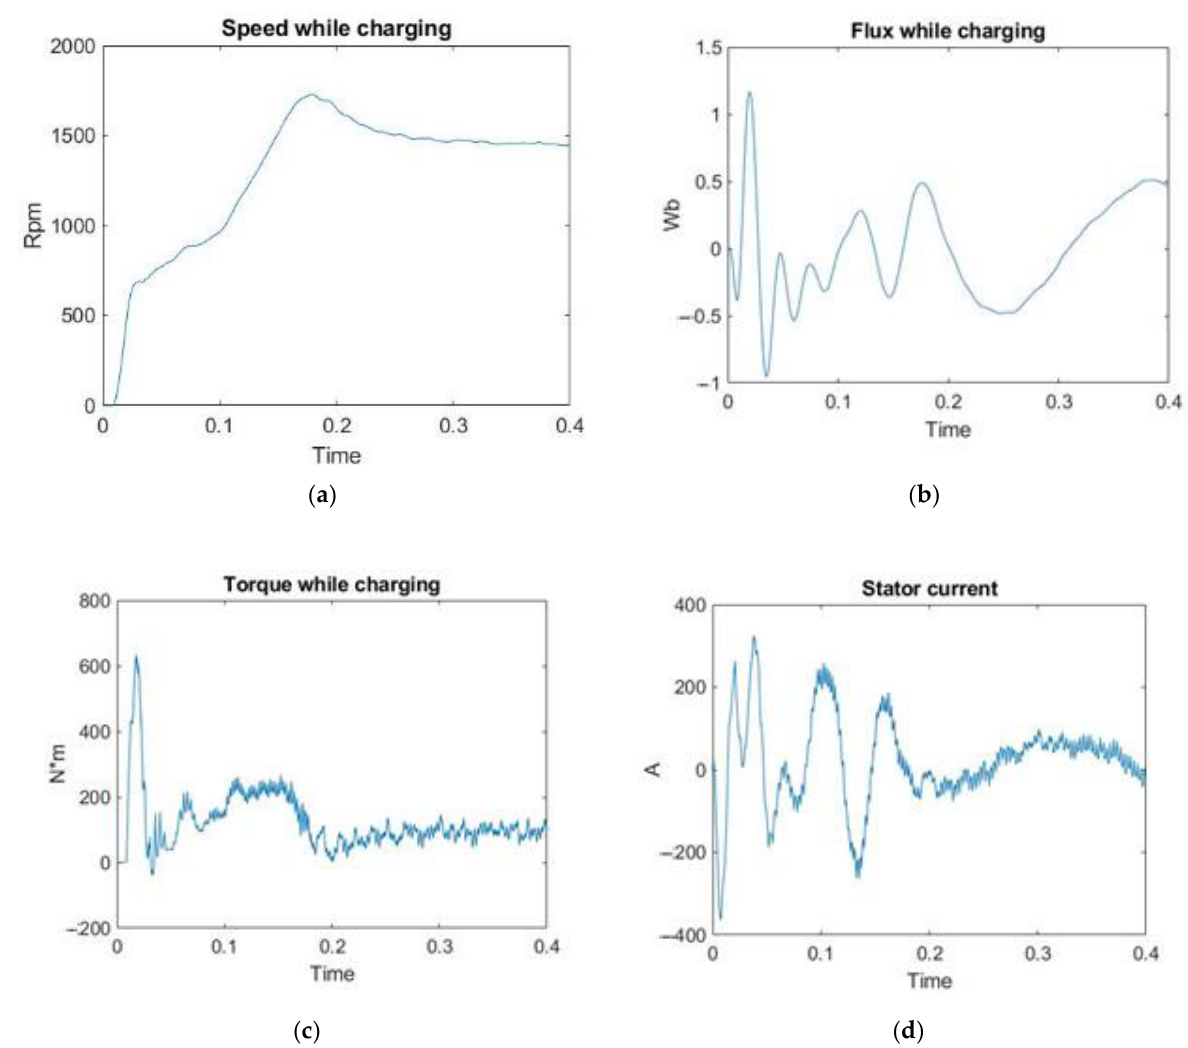
Figure 10. Output characteristics when charging a supercapacitor: ( a ) speed; ( b ) flux; ( c ) torque and ( d ) current.